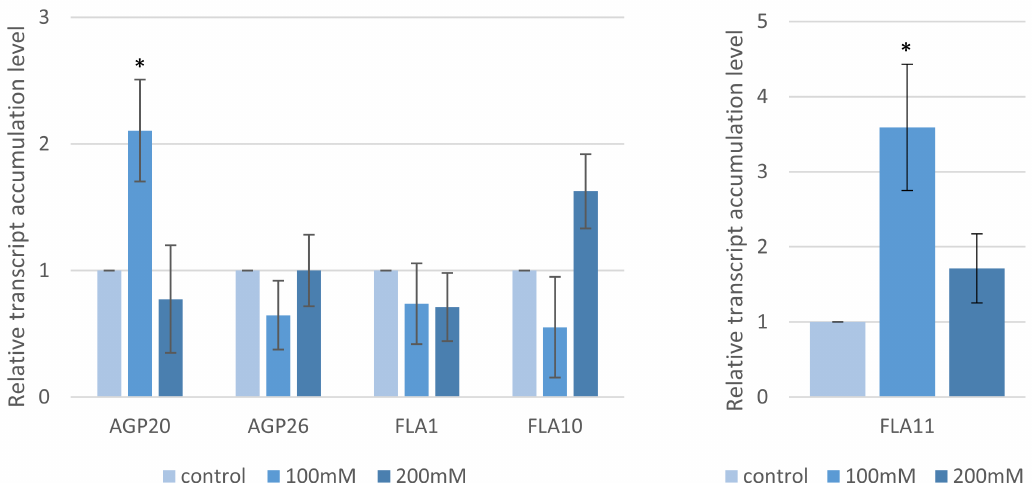
Figure 3. Relative level of the accumulation of the AGP and fasciclin–like AGP ( FLA ) genes after “salt shock” treatment with various concentrations of NaCl. The relative expression levels were normalized to an internal control (Bradi1g32860; encoding ubiquitin) and calibrated to the control. Asterisks indicate significant differences from the control using the Student’s t -test ( p < 0.05; mean ± SD, n = 3).